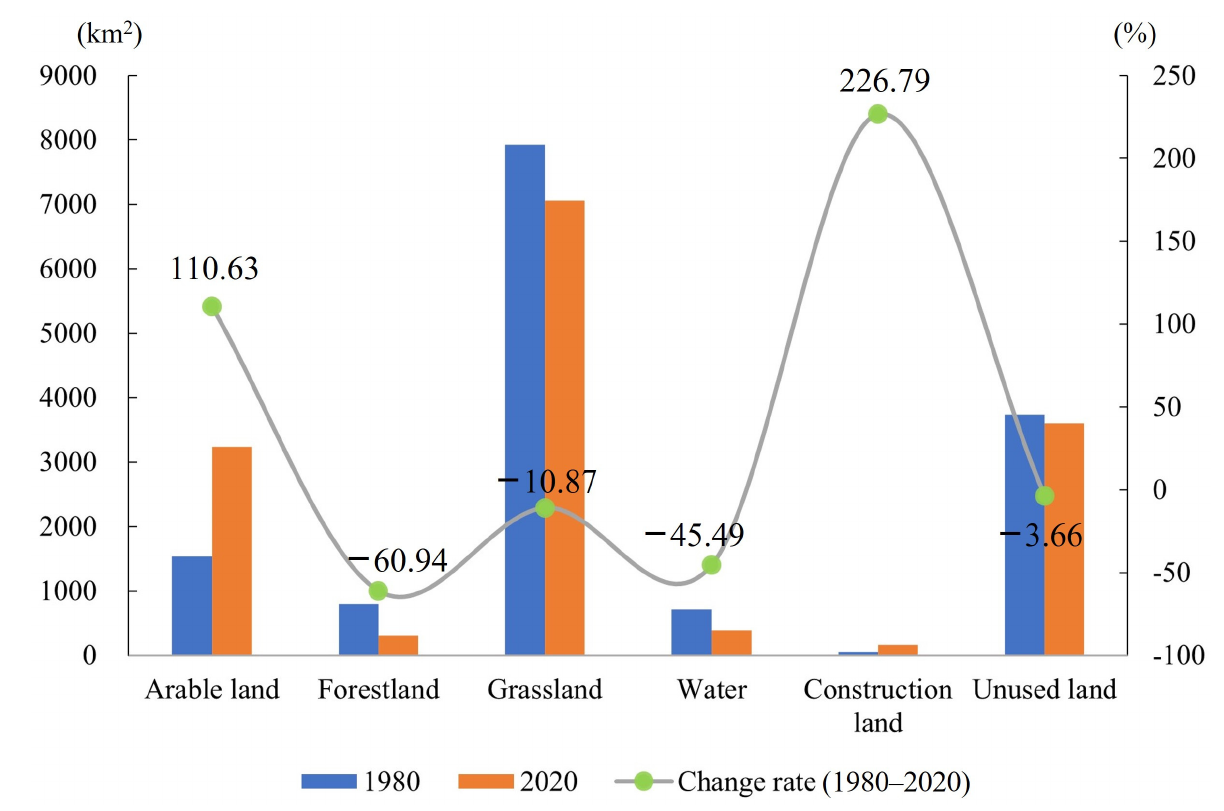
Figure 3. The change of land use from 1980 to 2020.